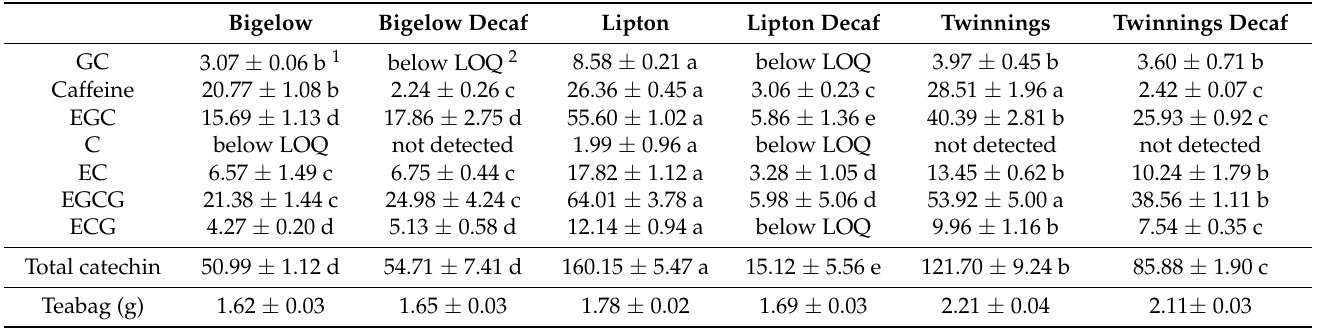
Table 2. Green tea catechin and caffeine content in mg per cup (235 mL) for six different tea brands prepared with deionized water.